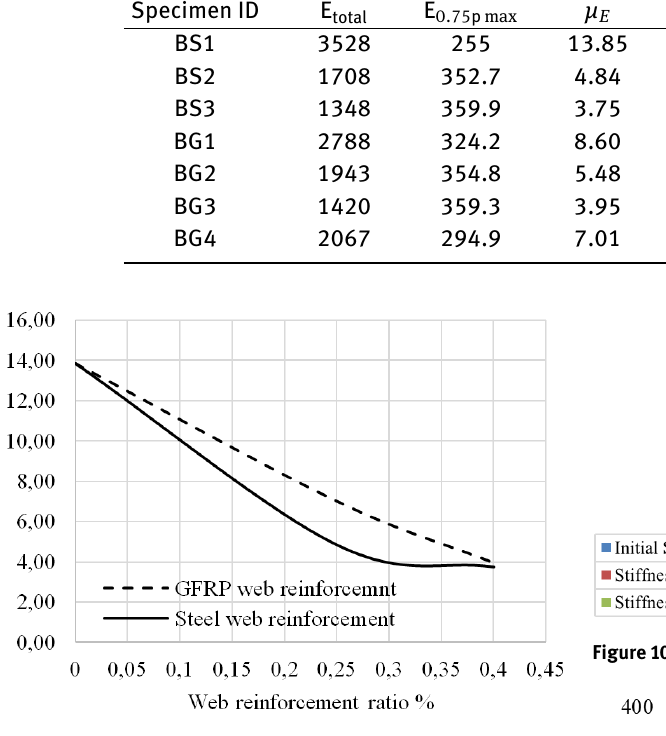
Figure 8: Relation between ductility index and web reinforcement ratio